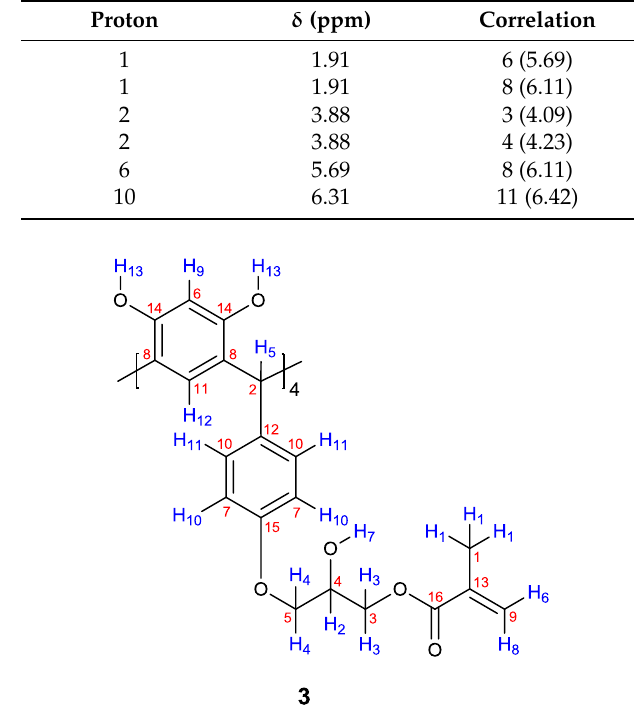
Figure 2. Compound 3 carbon and hydrogen assignments. Table 2. Correlations for compound 3 in the HMQC and HMBC